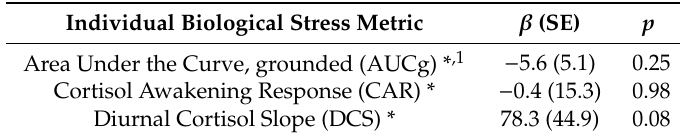
Table 3. Results of three independent models of biological stress measures (area under the curve, diurnal cortisol slope, cortisol awakening response) and infant birth